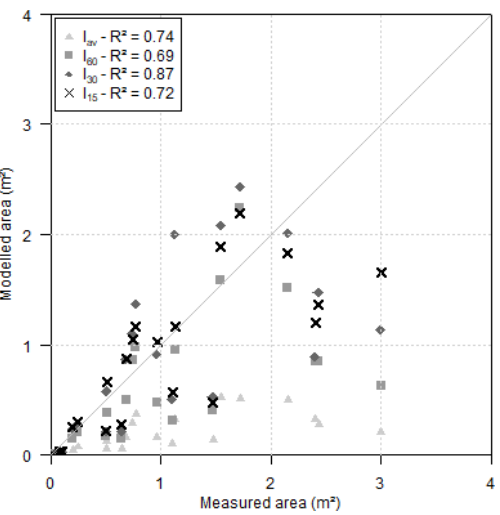
Figure 12. Taylor diagram comparing model performance. The az- imuthal distance gives the correlation ( R , Pearson). The distance to the origin is proportional to the standard deviation of the model values, and the distance to the reference (measured data) is propor- tional to the